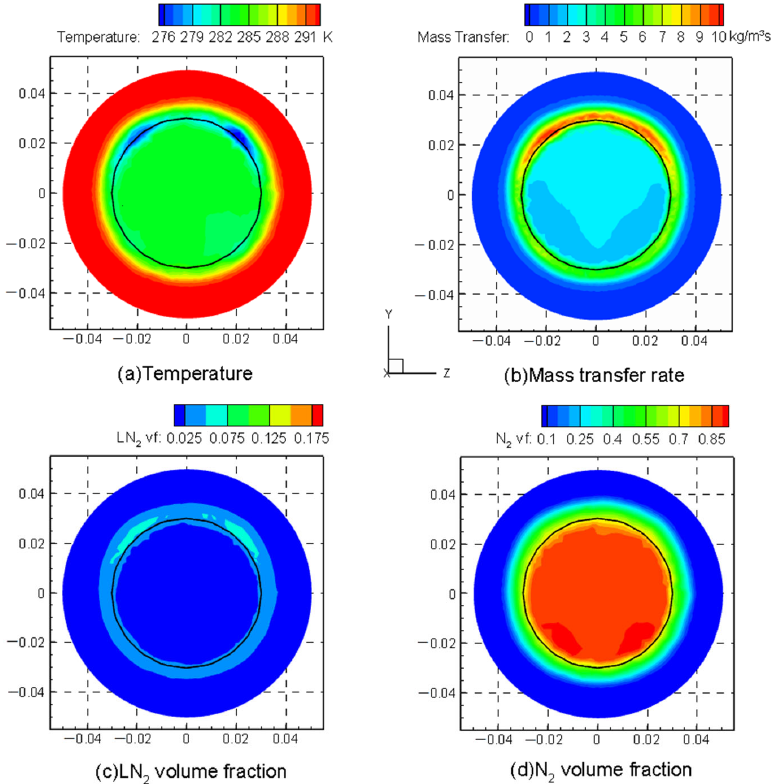
Figure 7. The distributions of the temperature ( a ), mass transfer rate ( b ), LN 2 volume fraction ( c ), and N 2 volume fraction ( d ) at x = 0.07 m (Case2 ‐ 2). and N 2 volume fraction ( d ) at x = 0.07 m